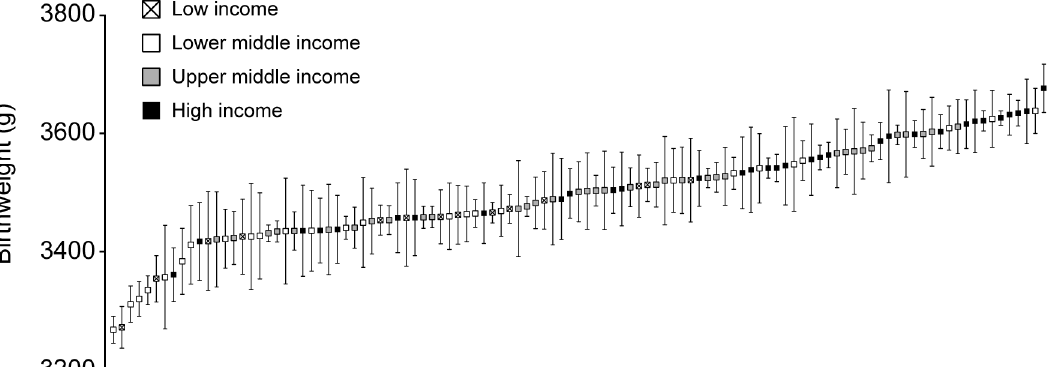
Fig 2. Unadjusted differences in the average birthweight between maternal countries of birth. The values represent the shrunken residuals and their confidence intervals obtained from the multilevel linear regression analysis.